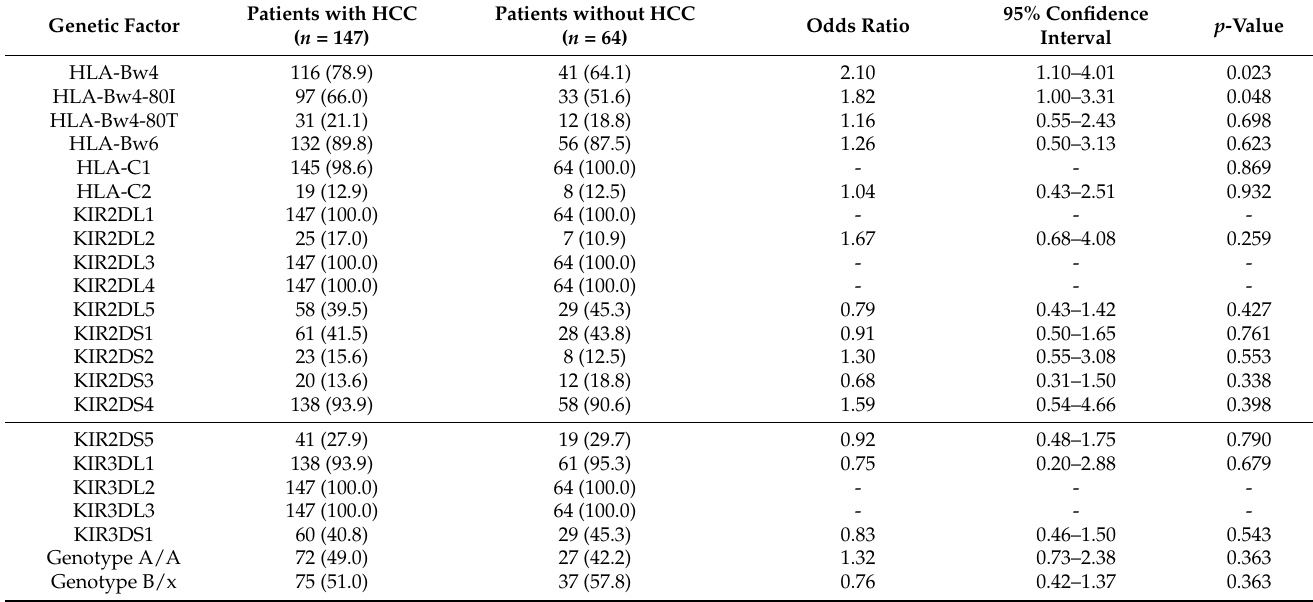
Table 2. Frequency of HLA-Bw4, -Bw6, -C1, -C2, killer cell immunoglobulin-like receptor (KIR) genes, and KIR genotypes in patients with and without hepatocellular carcinoma